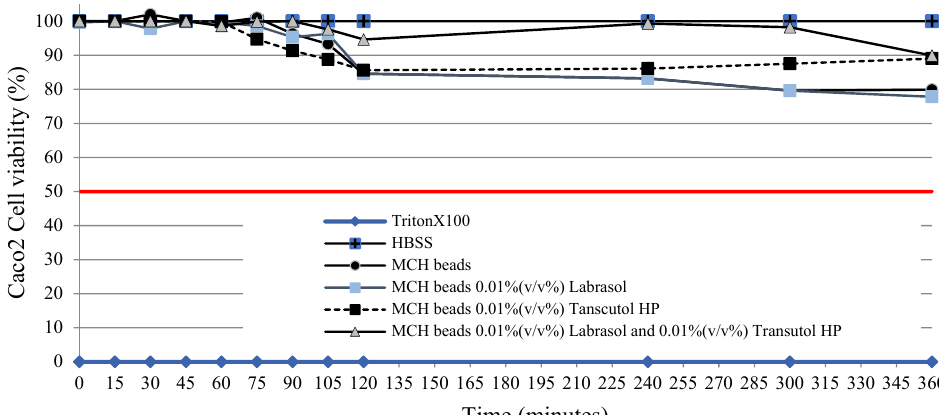
Figure 8. Results of a 6 h treatment of Caco-2 intestinal epithelial cells with MCH beads, MCH beads containing 0.01% ( v / v %) Labrasol, MCH beads containing 0.01% ( v / v %) Transcutol HP, and MCH beads containing 0.01% ( v / v %) Labrasol and 0.01% ( v / v %) Transcutol HP.